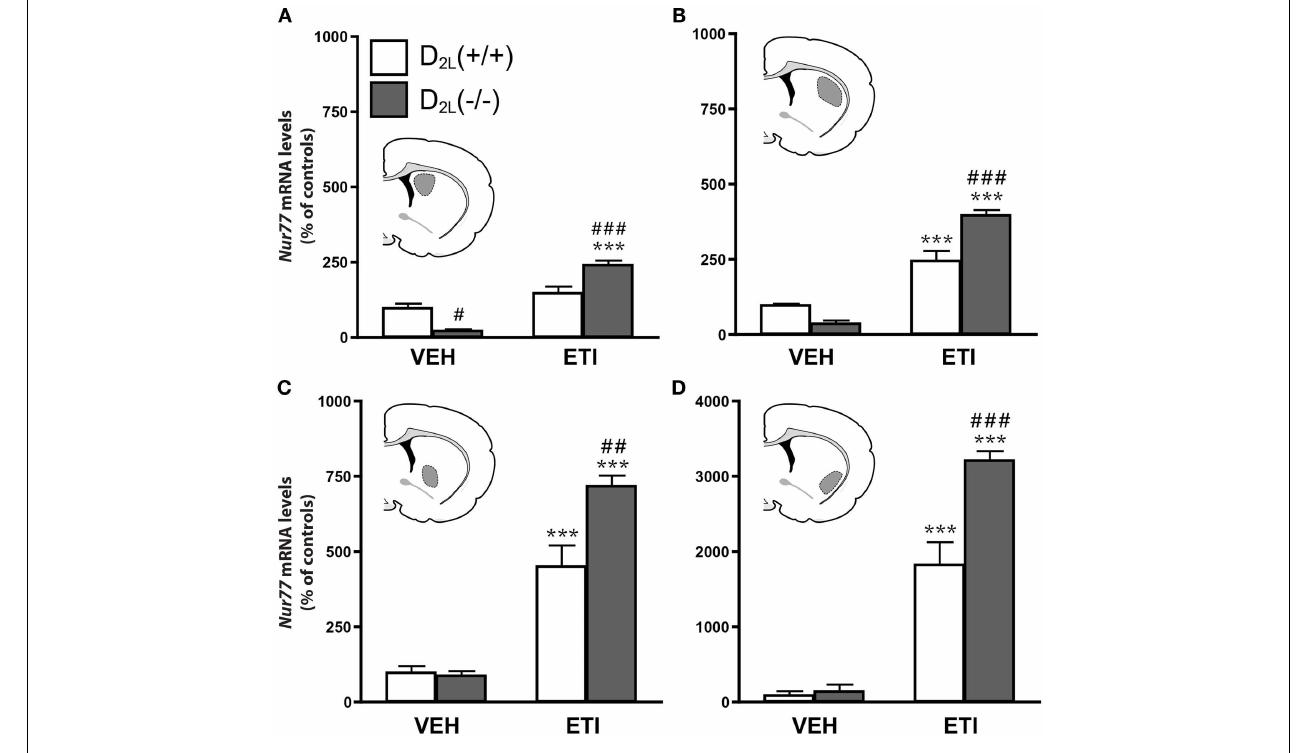
[D 2L ( + / + )]. Histograms represent mean ± SEM (*** p < 0.001 vs. vehicle (VEH) of the same strain, # p < 0.05 and ### p < 0.001 vs. eticlopride (ETI)-treated wild type [D 2L ( + / + )] mice, N = 8 per group). Insets represent drawings of specific striatal areas (in gray) used for